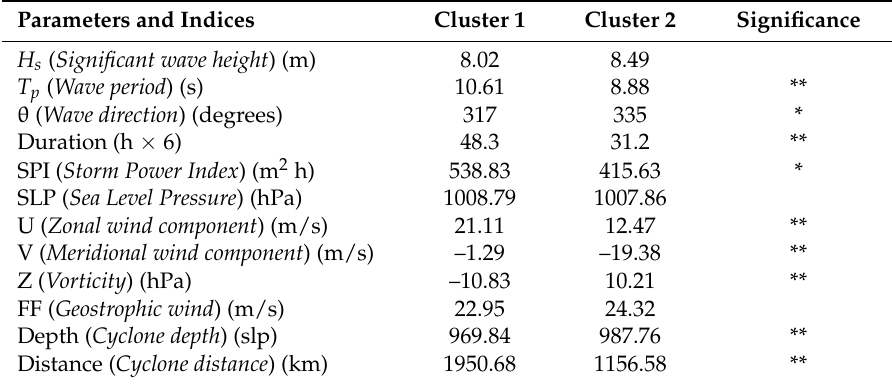
Table 3. Class-averaged values for each storm type resulting from a cluster analysis, and significance according to a Kruskall-Wallis test (*/** statistically significant at a 95%/99% confidence level).